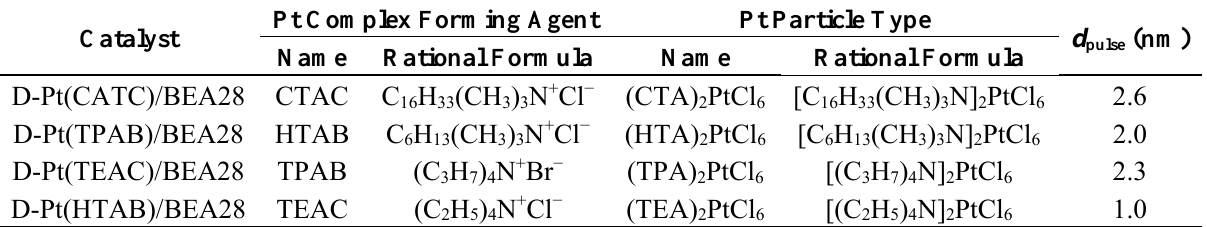
Table 5. Pt particles synthesized in w/o microemulsions and their d pulse